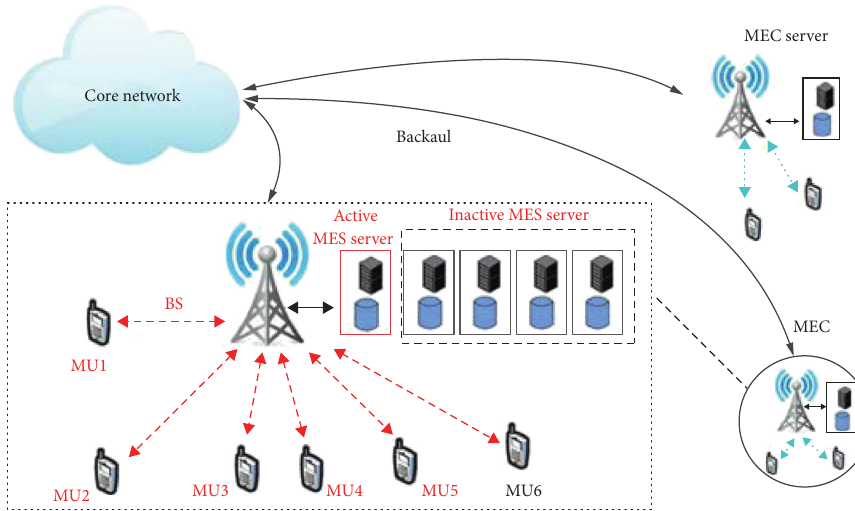
Figure 1: Division of edge computing scheduling